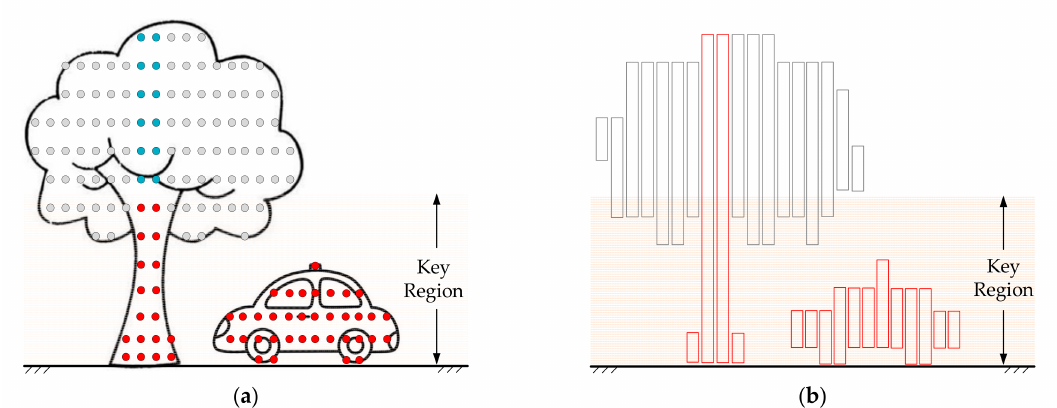
Figure 4. The schematic diagram of obtaining the major part of the object in the point cloud. ( a ) The point cloud of a tree and car scanned by a LiDAR sensor, where the red points belong to major parts within H mp , the blue points belong to major parts but above H mp , and the gray points belong to additional part. ( b ) The schematic diagram of slices of the point cloud, where red slices belong to major parts and gray slices belong to additional